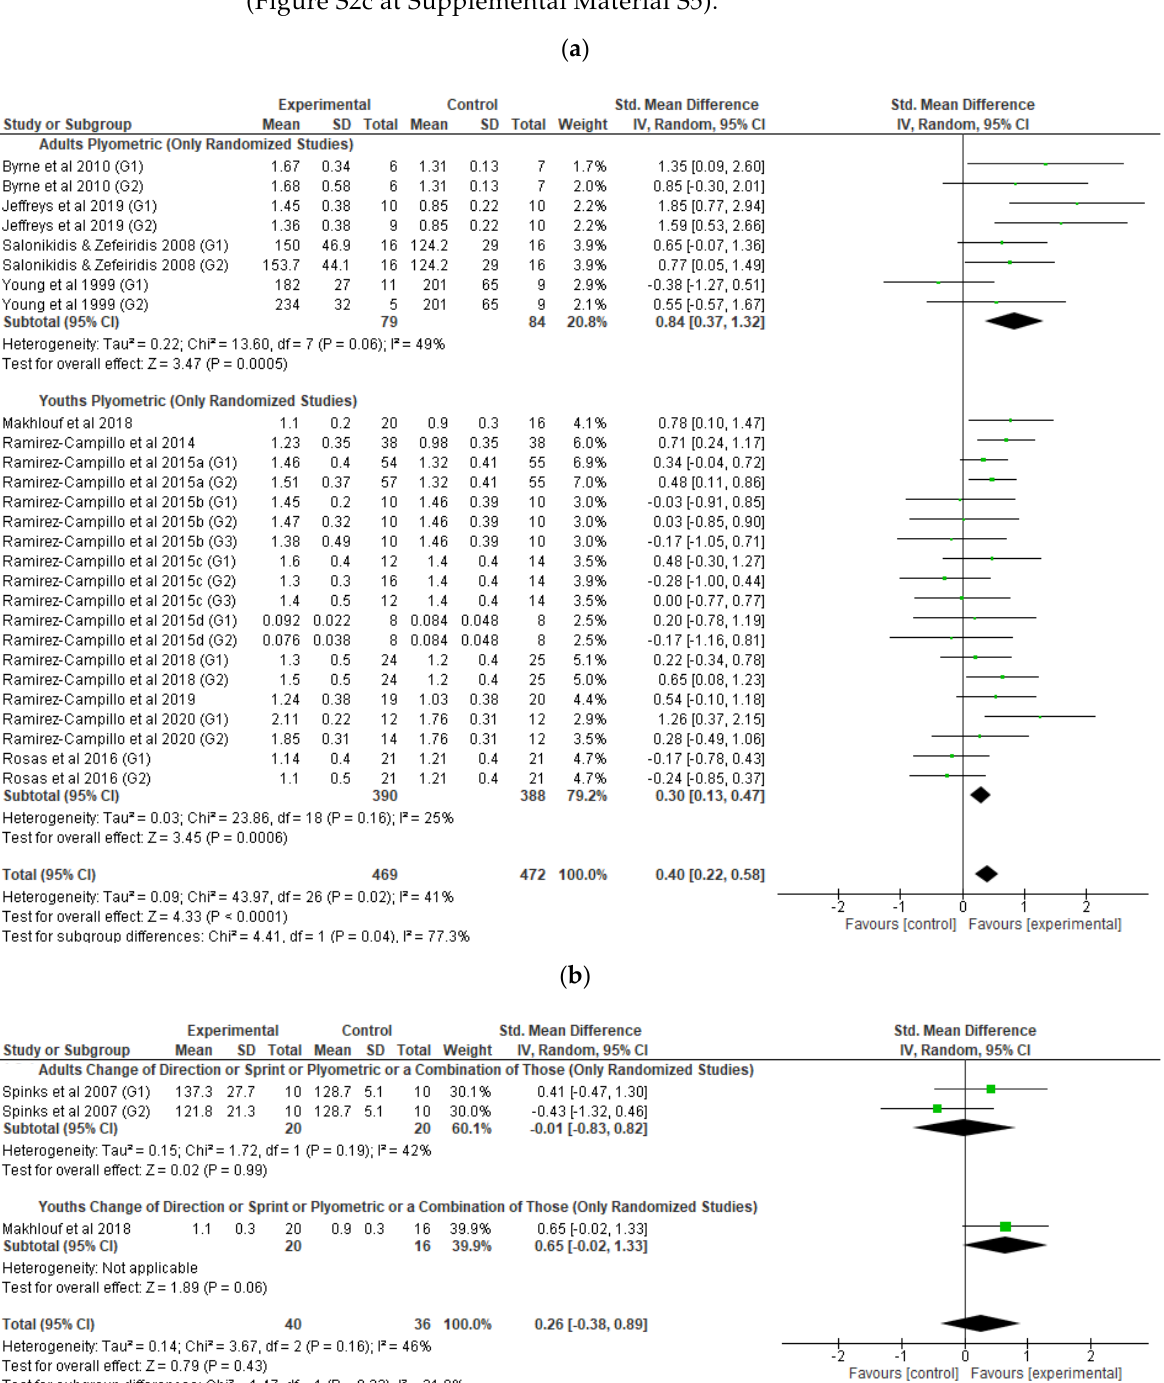
Figure 2. Forest plot of the overall standardized mean difference [95% CI] for each randomized study (the size of the green dot corresponds to the weight of the study within the meta-analysis) with control group with ( a ) a plyometric training intervention, and ( b ) combination of change of direction, sprint, or plyometric training intervention.